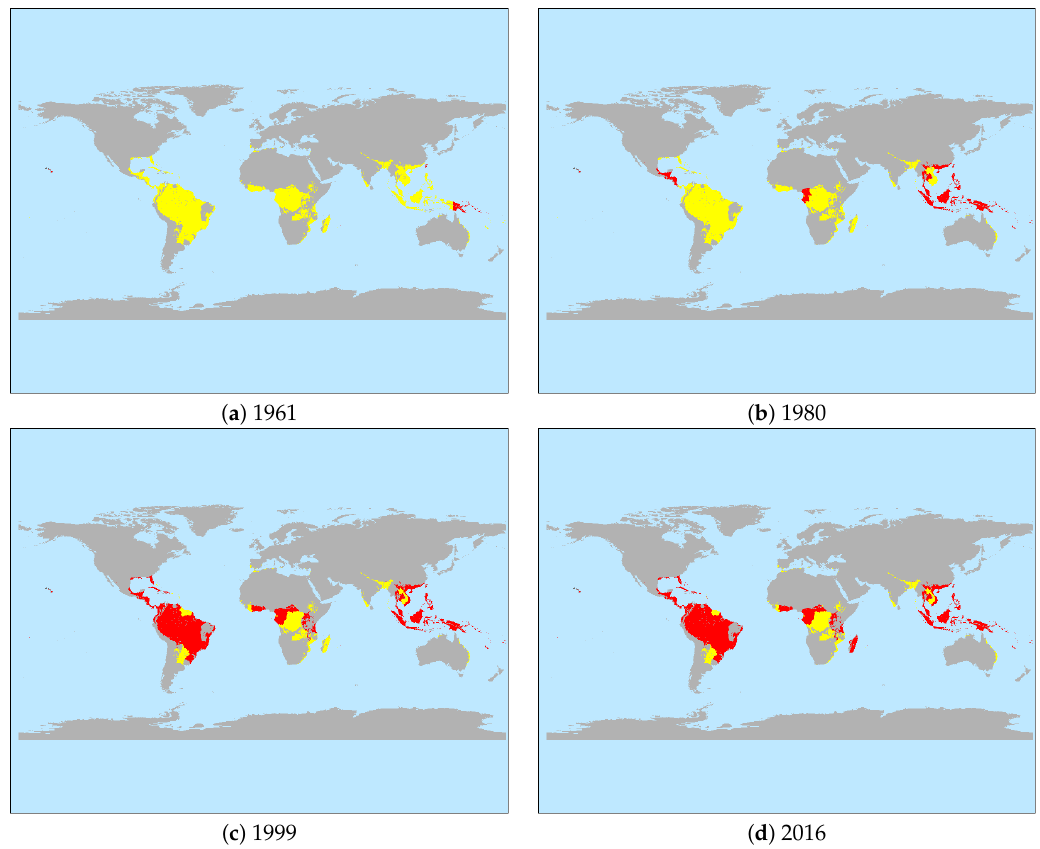
Figure 3. Temporal Spread of Black Sigatoka. Note: (i) This figures shows the distribution of countries where BSLD has been detected over time. (ii) Detected; Not